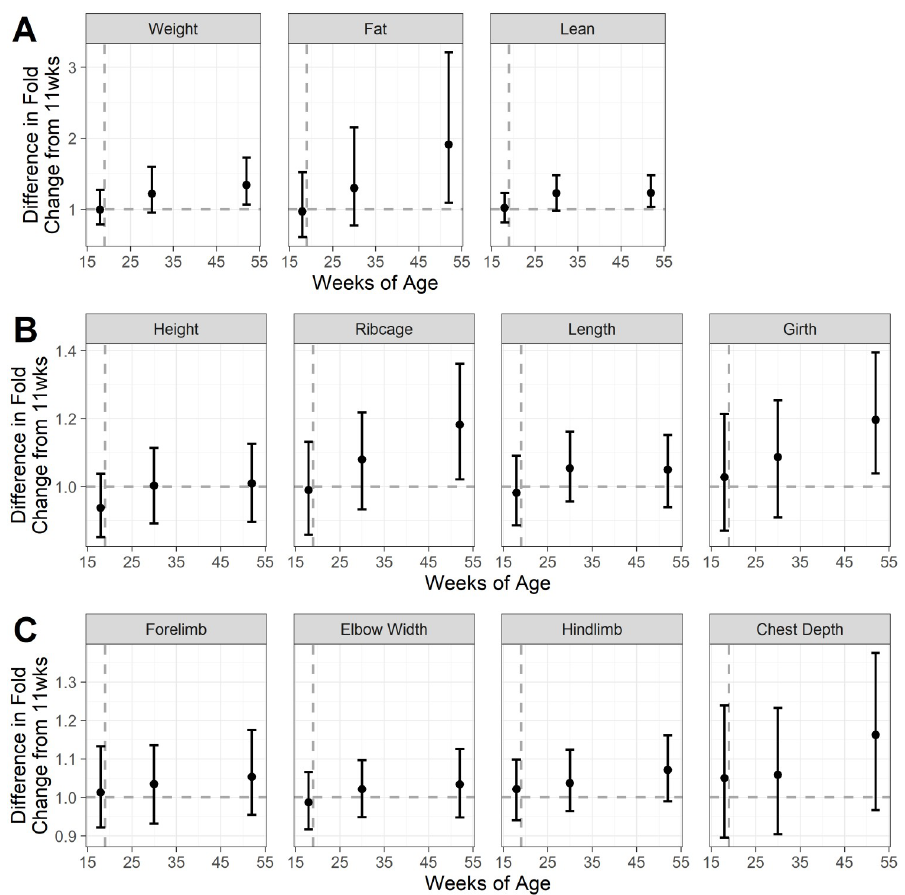
Fig 5. The estimated mean and 95% simultaneous credible intervals (difference between sexually-intact and neutered kittens (11 cats per group), in the fold-change for each measure, between 11 wk (when both groups were still sexually intact) and each subsequent timepoint. Black dots represent the mean values, whilst error bars represent the 95% simultaneous credible intervals; the vertical grey dashed line indicates age of neutering. Differences are shown as the fold change of the neutered group divided by the fold change of the sexually-intact group, so that values > 1 (shown by the horizontal dashed line) indicate that the neutered group had a greater difference in fold change. Panel A shows mass measurements, whilst and panels B and C show zoometric measurements. For details of the measurements see the legend for Fig